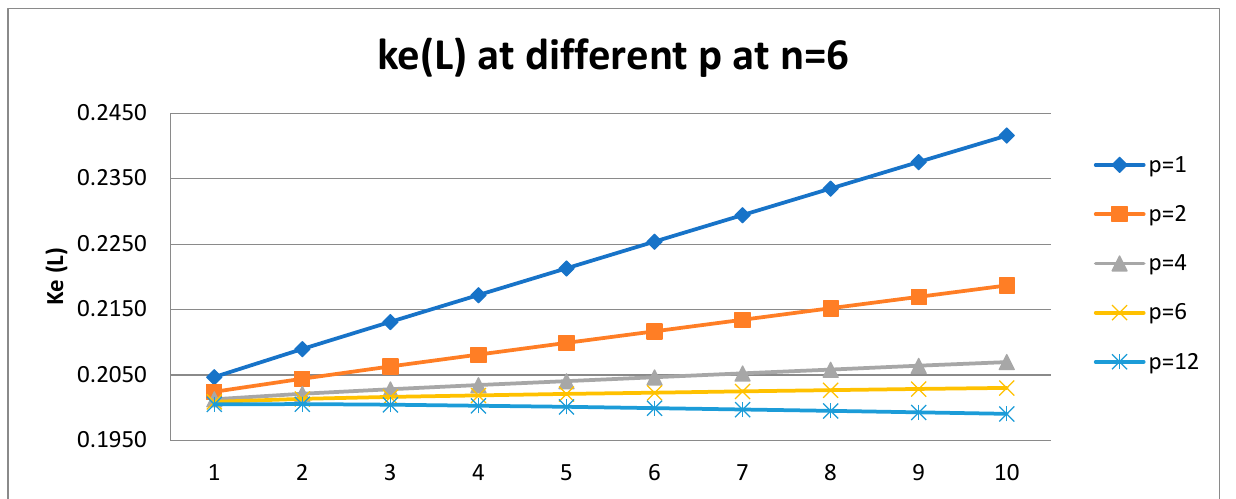
Figure 9. Dependence of the equity cost, k e , on leverage level L at different frequency of payments of tax on profit p for six-year company.